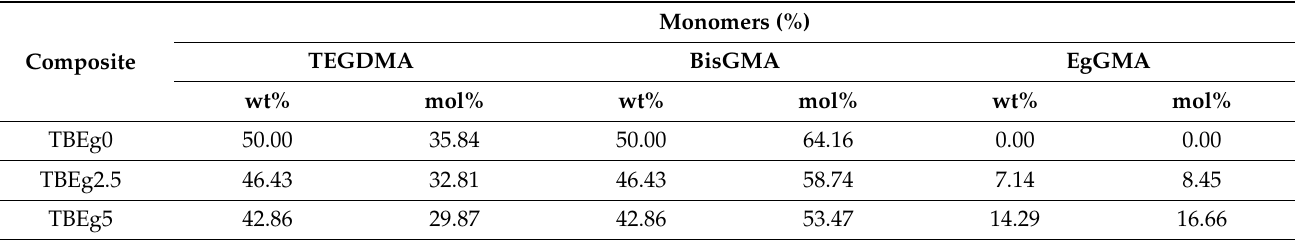
Table 1. Compositions of the experimental resin matrices.